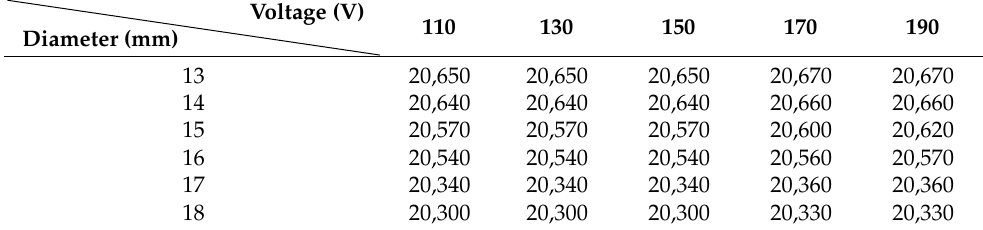
Table 1. The resonant frequencies after filling with water at different